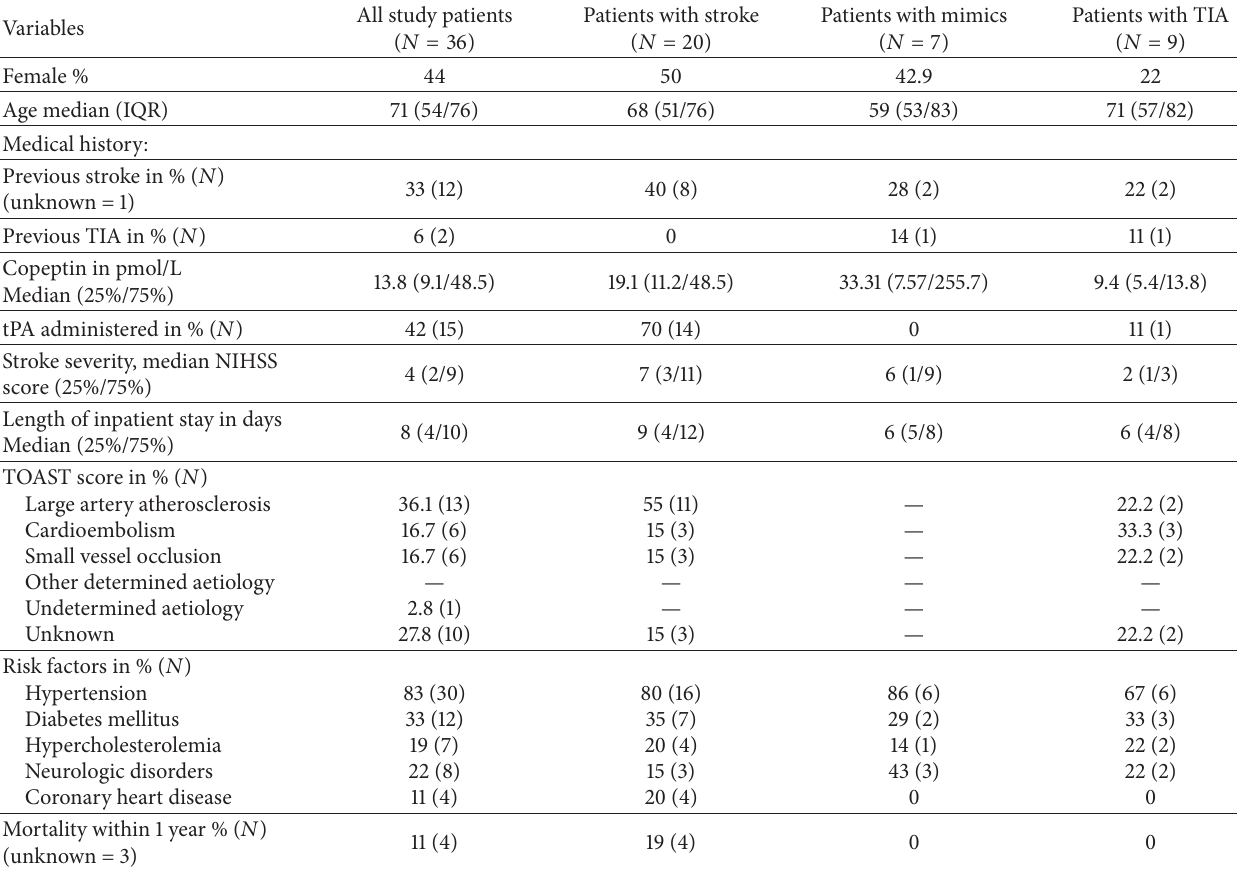
Table 1: Patients’